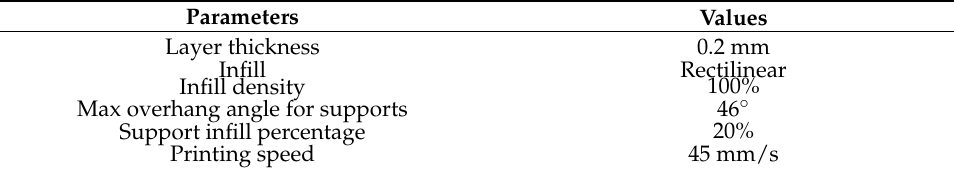
Table 7. Printing